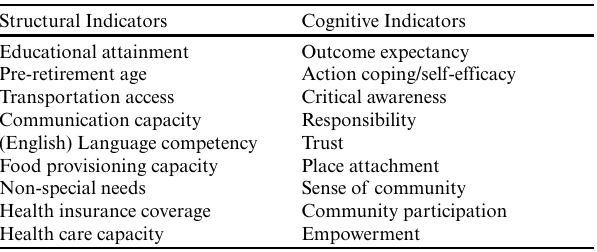
Table 2 . Social resilience indicators (adapted after Kwok et